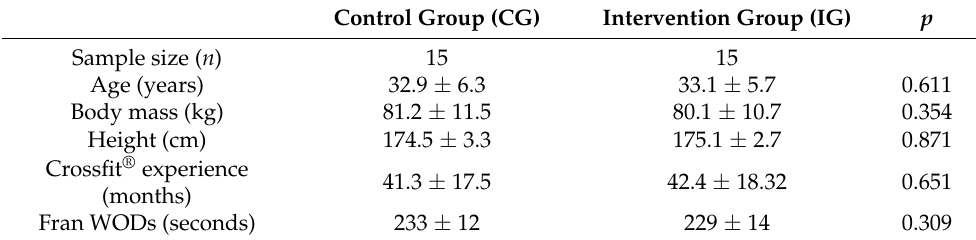
Table 1. Characteristics of study